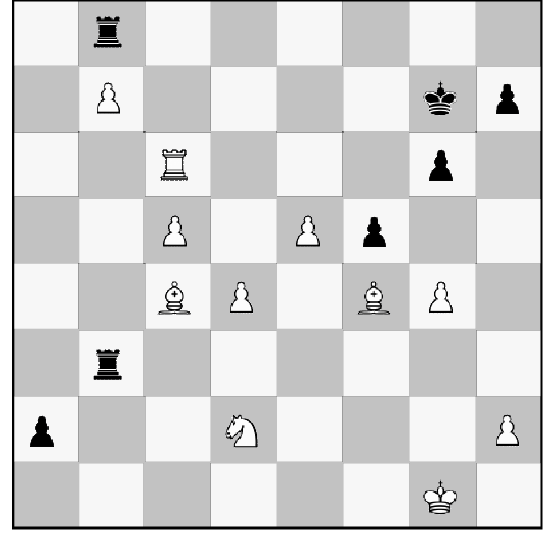
Figure 4: Stimulus presented to